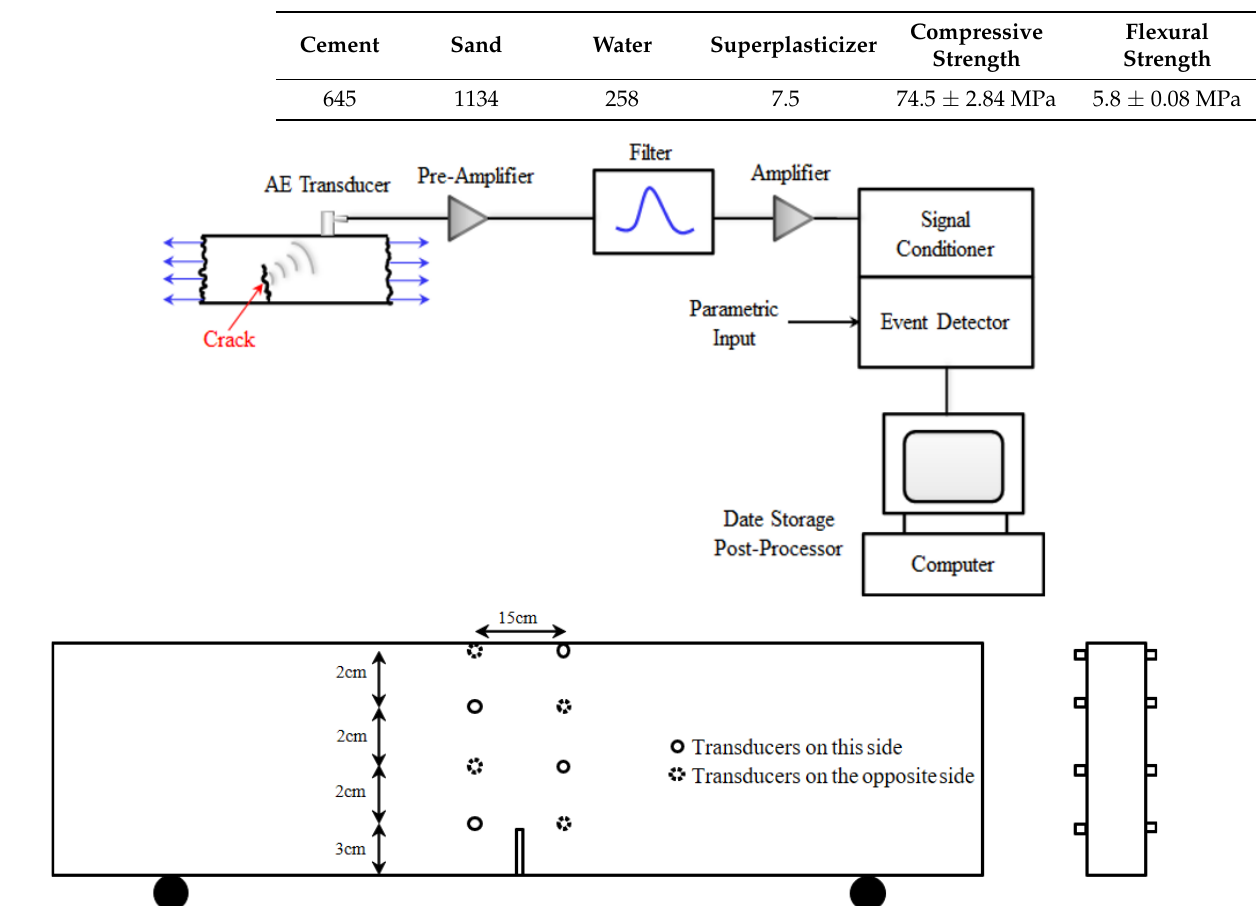
Figure 3. Schematics of AE instrumentation and positions of AE transducers.